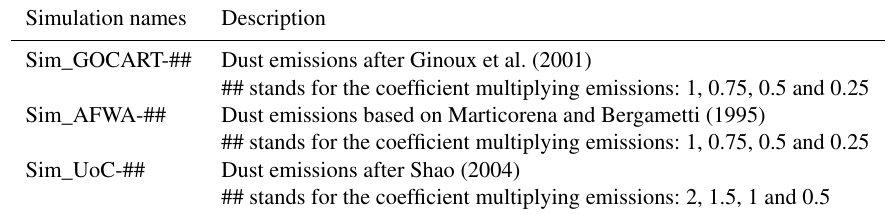
Table 1. Simulations description. Simulation